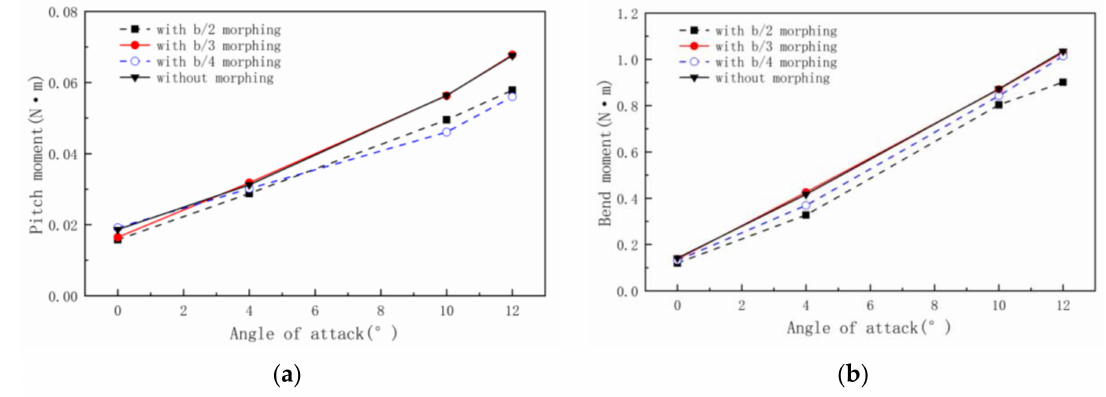
Figure 17. ( a ) Pitch moment and ( b ) bend moment of different wing models at different